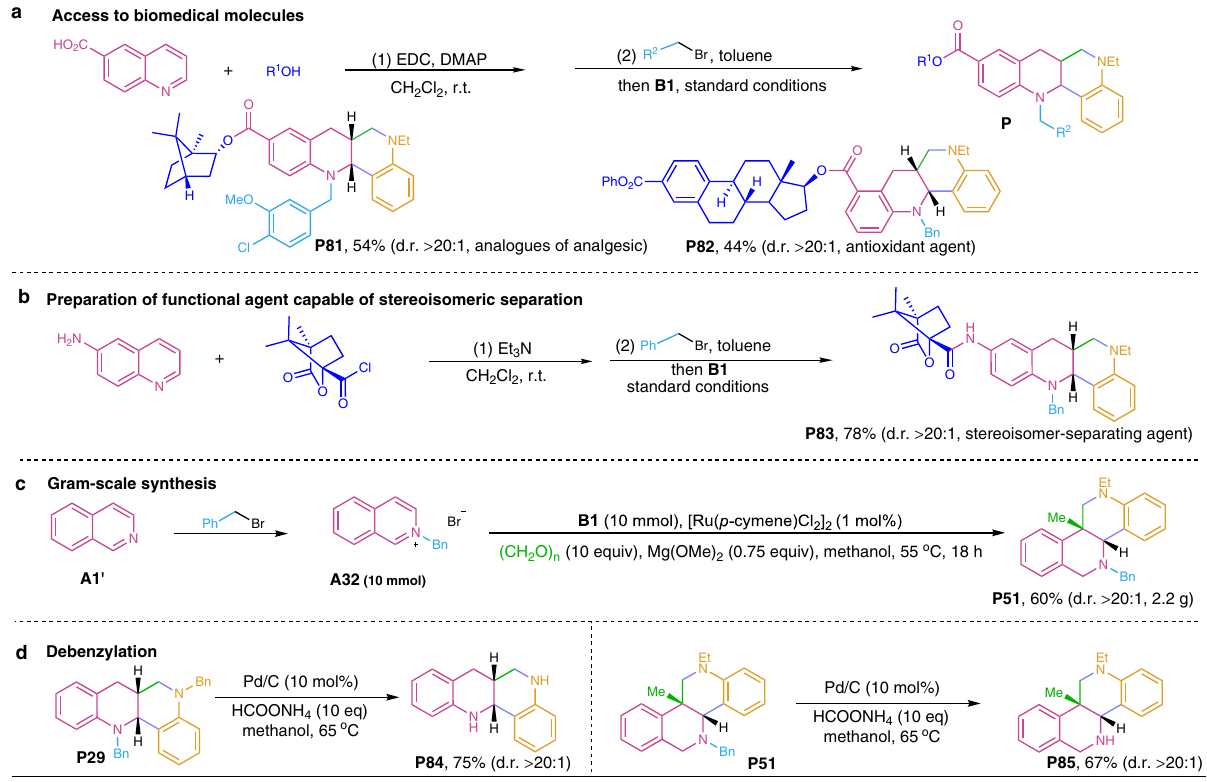
Fig. 5 Synthetic applications of the developed chemistry. a , b Structural modi fi cation of biomedical molecules. c Gram-scale synthesis. d Debenzylation of P29 and P51 .